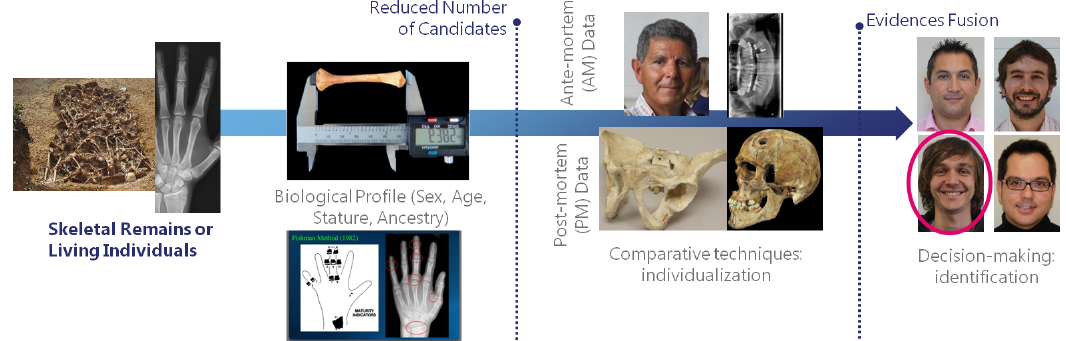
Figure 2. Skeleton-based forensic identification (SFI) pipeline. These techniques can be applied for positive identification and potential candidates reduction (or shortlisting) of both living and dead individuals. They are commonly employed when other ID techniques (e.g., DNA or fingerprint comparison) are not applicable, or in combination with